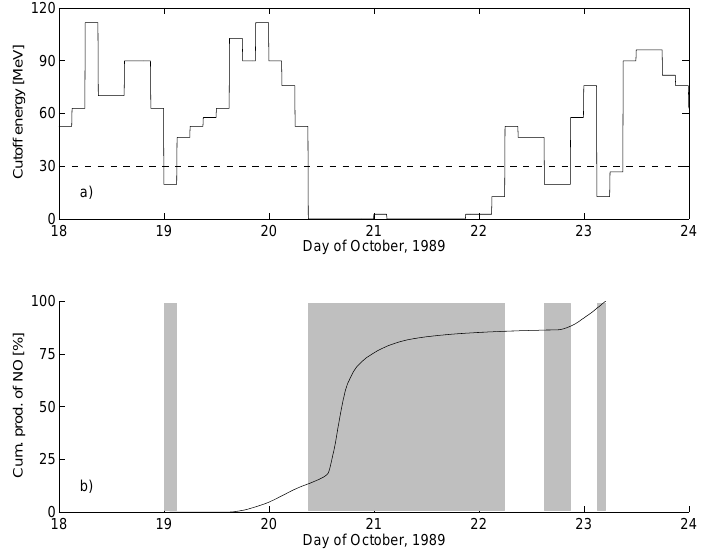
Fig. 4. (a) Calculated magnetic rigidity cutoff energies for the rocket measurement location. (b) Cumulative production of NO at 50km from 18 October to 23 October 05:00 UT (model results, no cutoff applied). The shaded areas indicate the times of NO production when taking into account the variation with time of the cutoff energy.